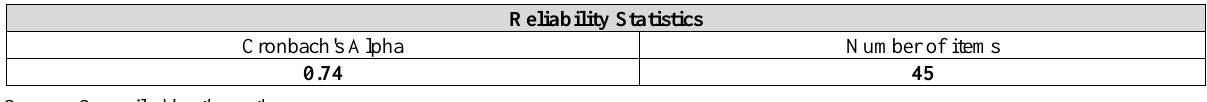
Table 1. Reliability